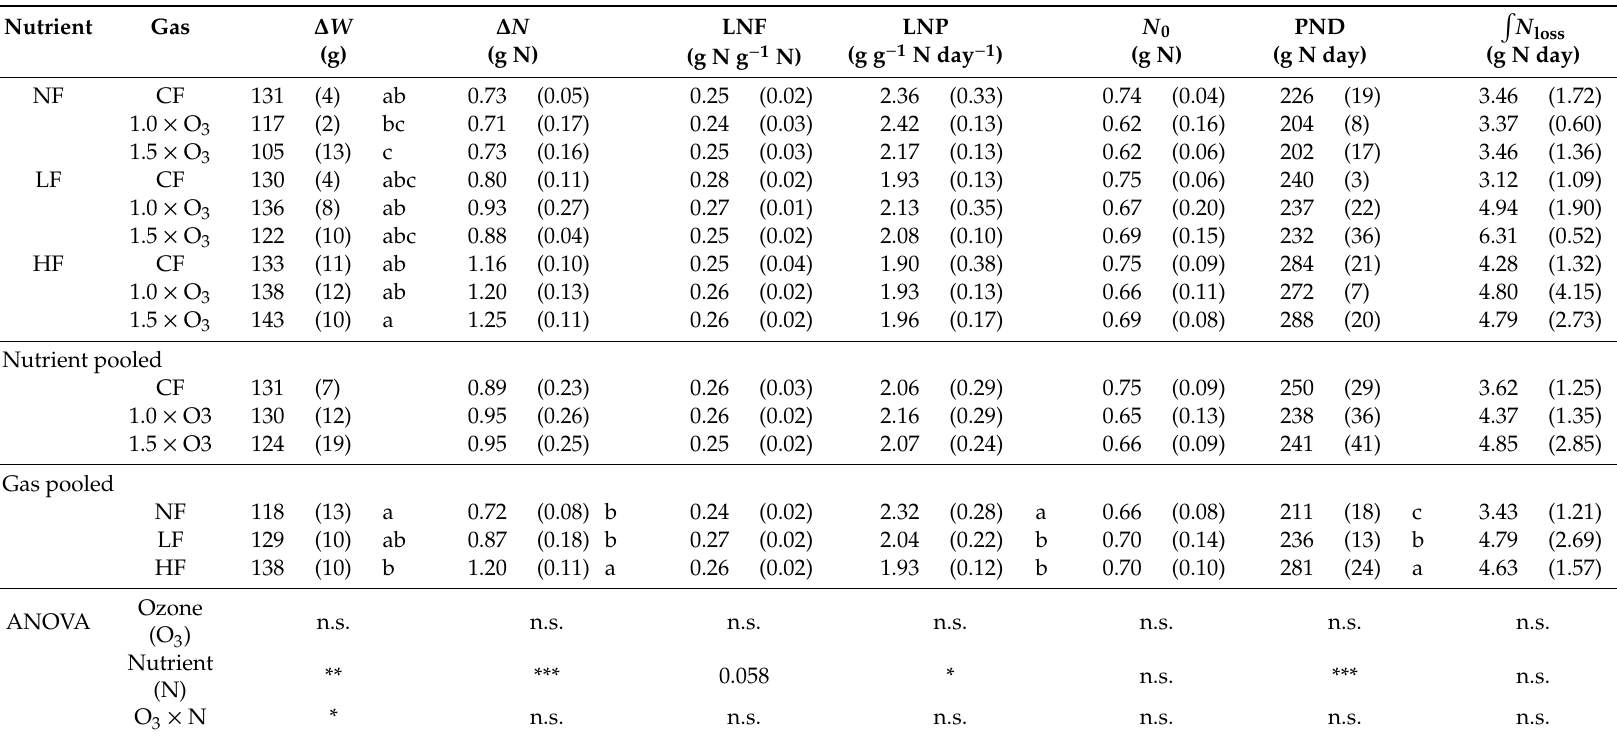
Table 2. Components of nitrogen use e ffi ciency: whole-plant biomass growth ( ∆ W ), nitrogen uptake ( ∆ N ), leaf nitrogen fraction (LNF), leaf nitrogen productivity (LNP), initial whole-plant nitrogen content ( N 0 ), plant nitrogen duration (PND) and time-integral of nitrogen loss ( growing